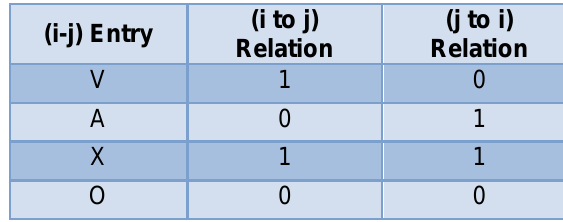
Table 2 Rule for transforming SSIM to